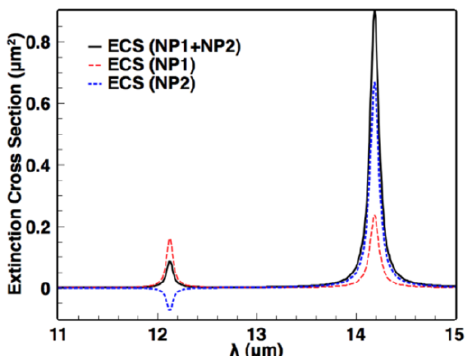
Figure6. Extinctioncross-sectionspectrumoftotal(blacksolid), NP1(reddashed), andNP2(bluedotted) contributions from the graphene-wrapped dimer.